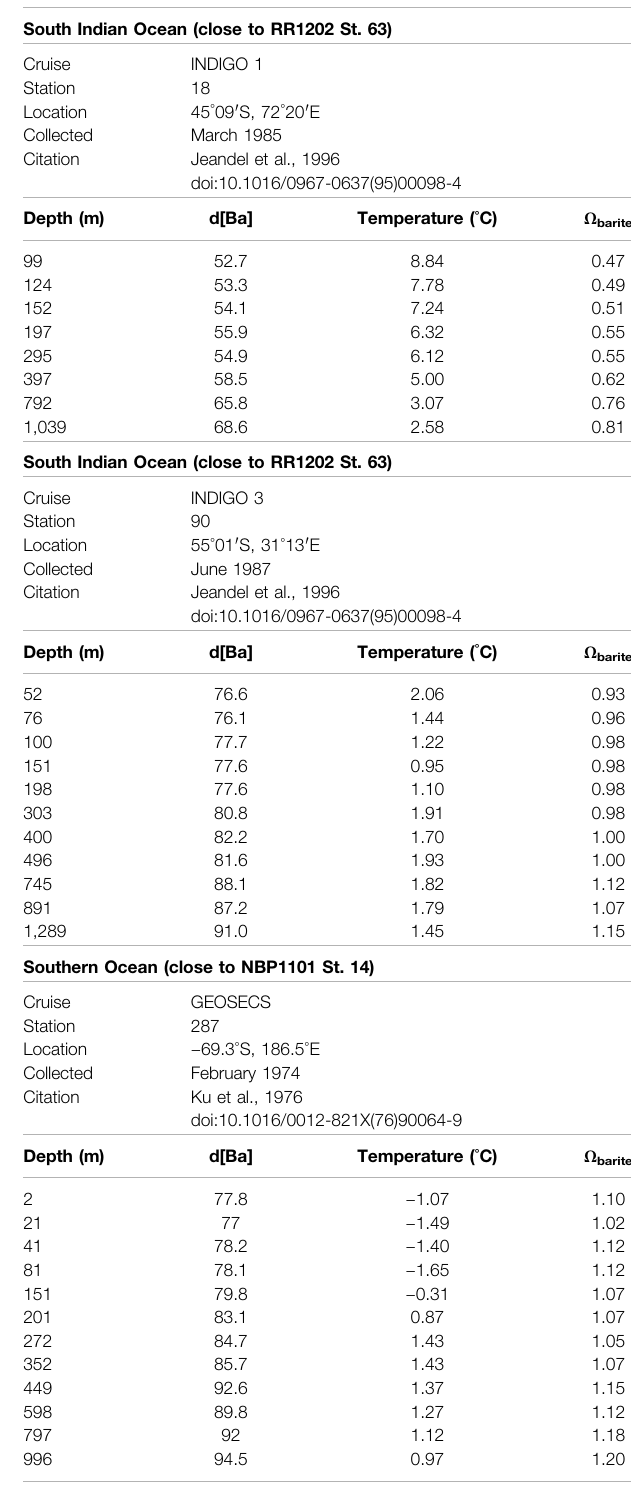
TABLE 2 | ( Continued ) Dissolved Ba, temperature, and calculated pro fi les of dissolved Ω barite acrossdepthinnearbystationstothoseanalyzedinthiswork (co-located dissolved samples were generally not available for our